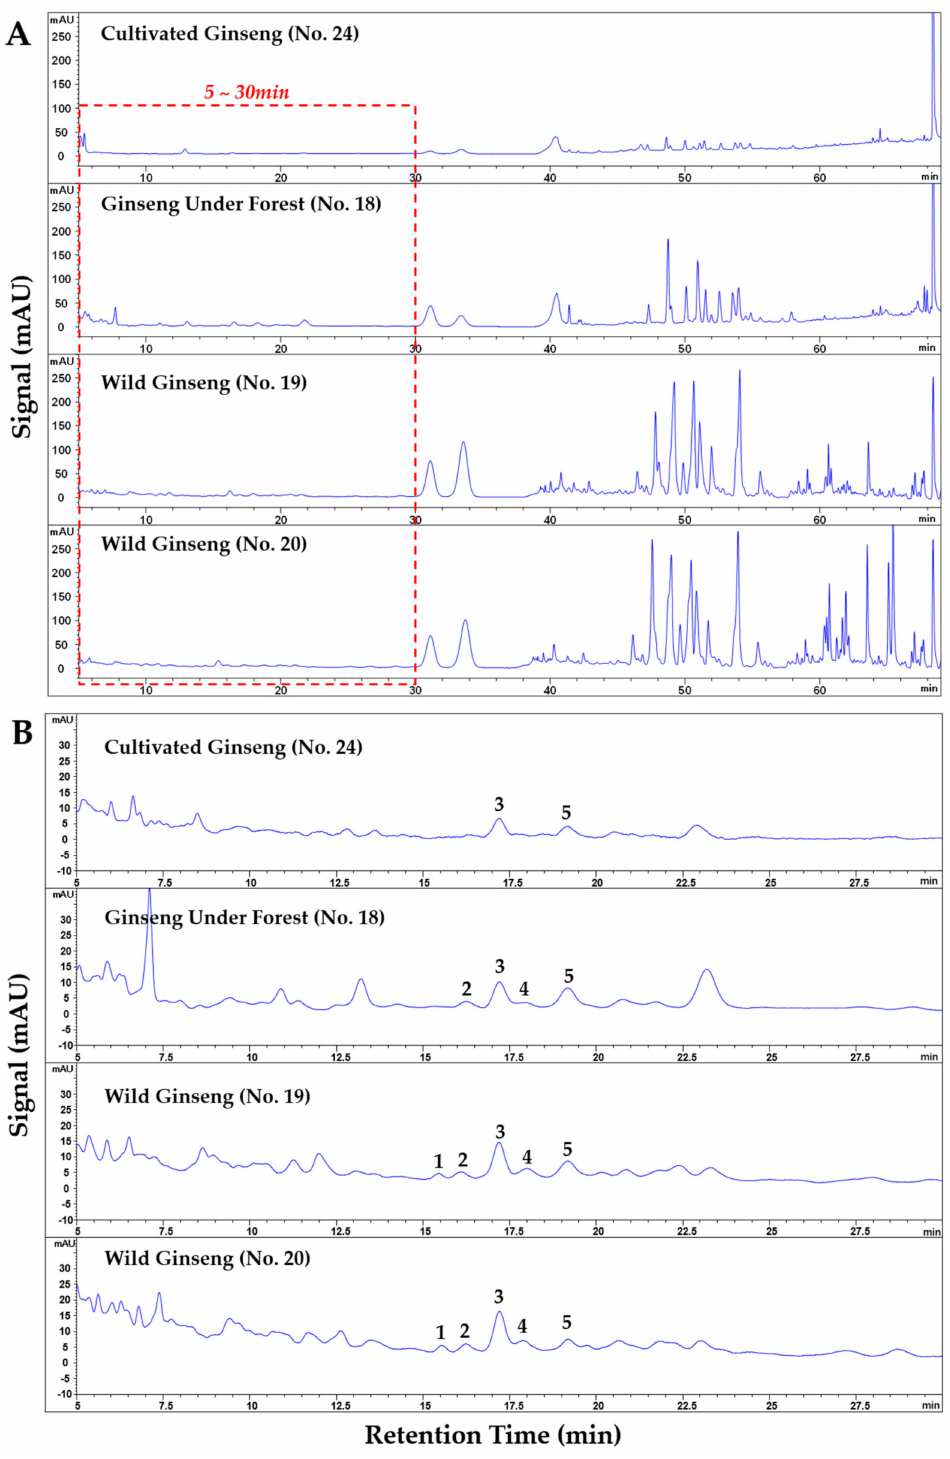
Figure 5. Chromatograms (retention time: 5–70 min) of cultivated ginseng (no. 24), ginseng under forest (no. 18), wild ginseng (no. 19, ~50 years old; no. 20, ~100 years old; ( A )), as well as their zoomed-in chromatograms (5–30min) labeled with the five characteristic peaks in Section 2.5 [( B ); 1, (B4-b)-glc-xyl; 2, (B3-b)-glc-rha; 3, ginsenoside Re 4 (or its isomer); 4, 25-hydroxy-ginsenoside Rg 2 ; 5, (B3-b)/B6-glc-xyl tentatively identified via HPLC-IT-TOF-MS n